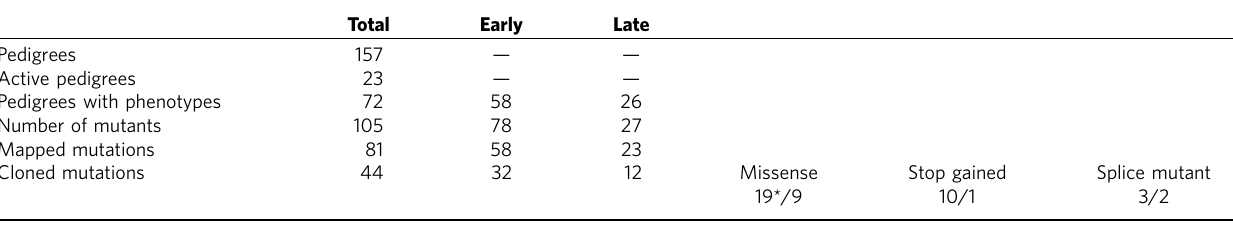
Table 2 | Summary of output from the ENU screen including number of pedigrees analysed along with mutant discovery and mutations